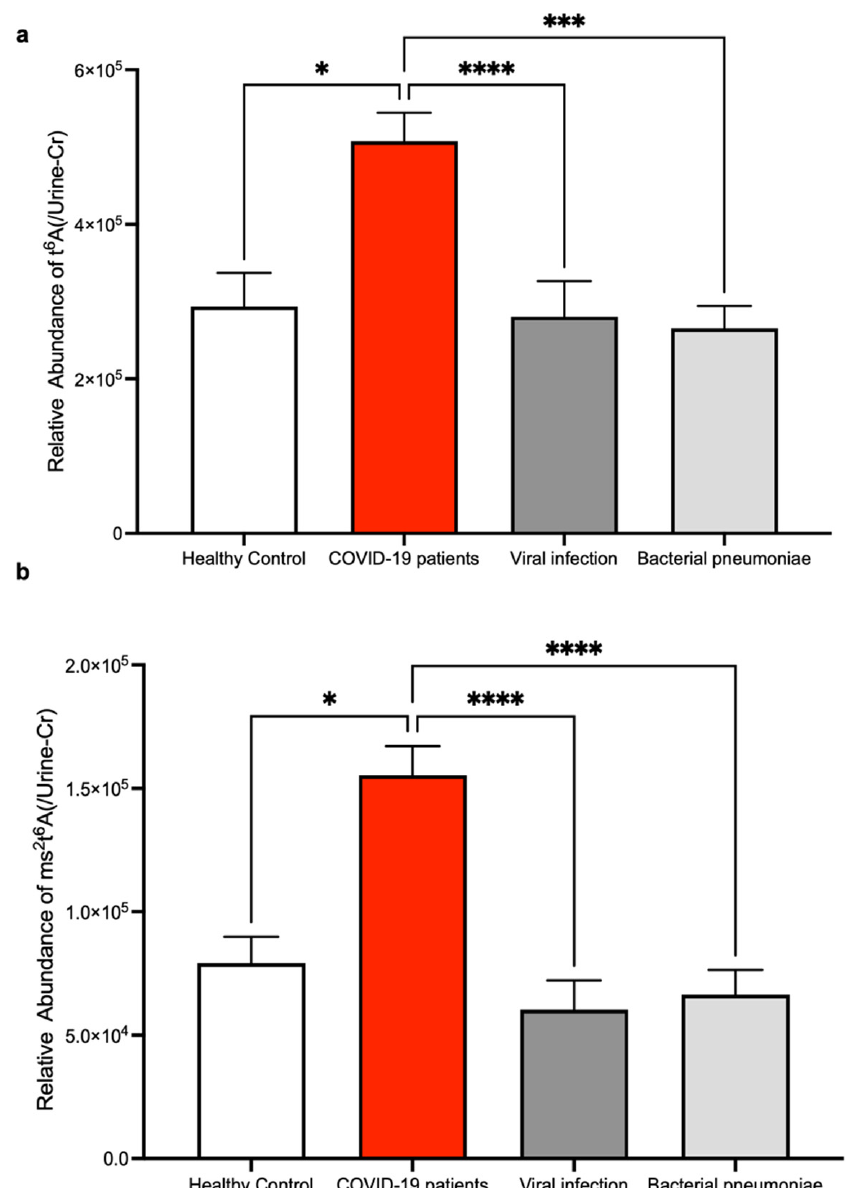
Figure 3. The comparison of t 6 A and ms 2 t 6 A levels in the urine of COVID-19 patients with other infectious diseases. ( a , b ) Comparison of t 6 A ( a ) and ms 2 t 6 A ( b ) levels in the urine of patients with viral infection or bacterial pneumoniae. LC-MS peak areas of t 6 A and ms 2 t 6 A divided by urine creatinine levels are shown. * p < 0.05, *** p < 0.001, **** p < 0.0001 by Kruskal–Wallis test and Dunn’s multiple comparison test.